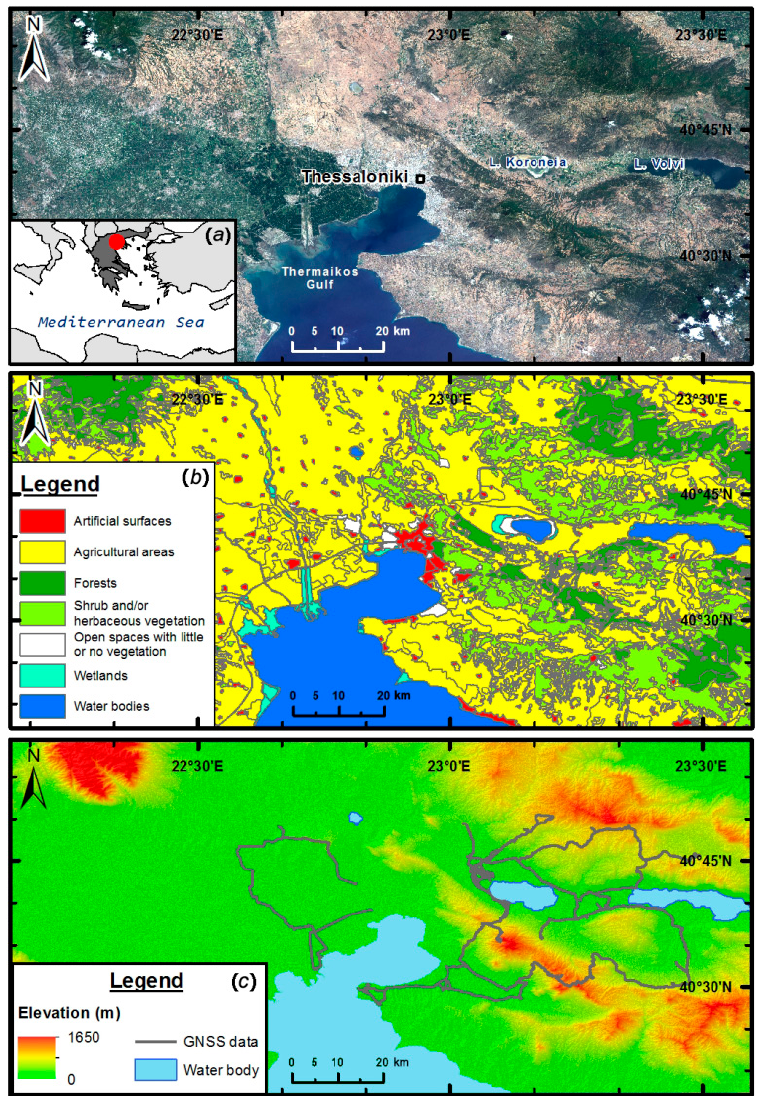
Figure 1. ( a ) Broad overview of the study area, as seen in a Landsat-8OLI (Operational Land Imager) true color composite image; ( b ) land cover of the study area according to Corine Land Cover data; and ( c ) topography of the study area and tracks of Global Navigation Satellite Systems (GNSS) data collected for DEM validation purposes.